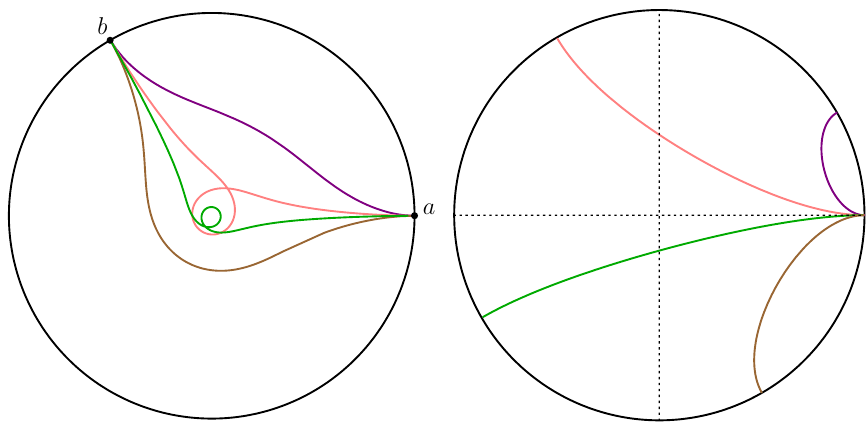
Figure 1 . Left: the n geodesics between the boundary points a and b , which delineate a region A , in the conical defect geometry AdS the same geodesics from the perspective of the covering space AdS